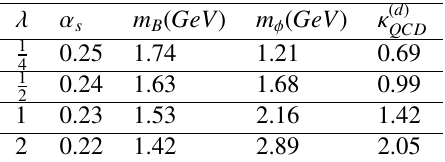
Table 1. The masses of vector and scalar glueball as functions of α s